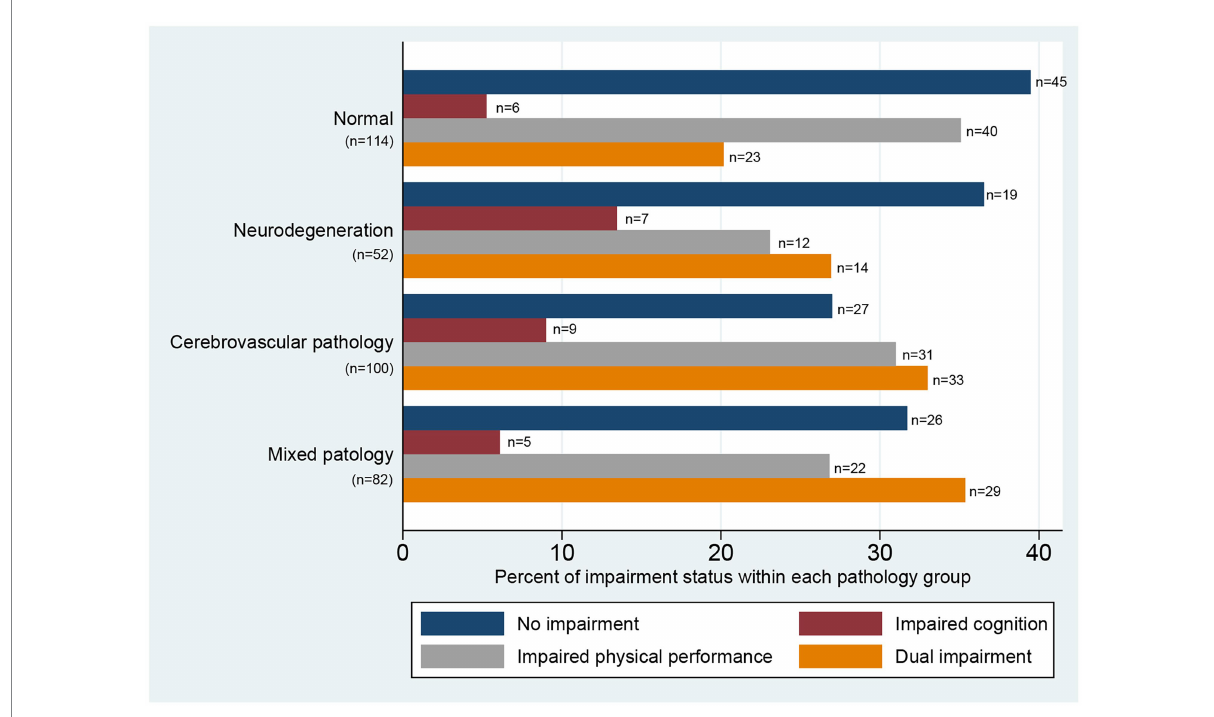
FIGURE 2 Distribution of impairment status within pathology groups illustrated by percentages within each pathology group. No impairment = Short Physical Performance Battery (SPPB) ≥ 10p and Montreal Cognitive Assessment (MoCA) ≥ 24p; impaired cognition = SPPB ≥ 10p and MoCA <24p; impaired physical performance = SPPB <10p and MoCA ≥ 24p; dual impairment = SPPB <10p and MoCA <24p. Vascular pathology: Pathological white matter hyperintensities score or presence of old infarcts, lacunes or ≥ 2 microbleeds. Neurodegeneration: Pathological medial temporal lobe atrophy, posterior atrophy, or ventricular enlargement. Mixed pathology: Presence of both vascular pathology and